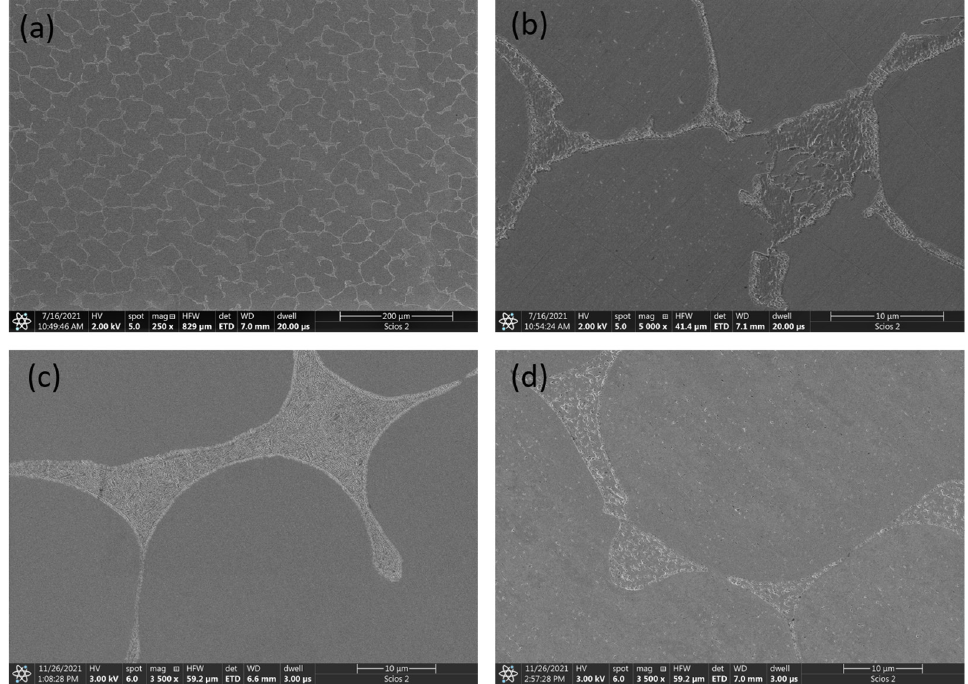
Figure 6. SEM micrographs of Al 0 . 5 CoCrFeNi alloy: ( a , b ) as ‐ cast, ( c ) annealed at 500 °C, and ( d ) annealed at 900 °C.